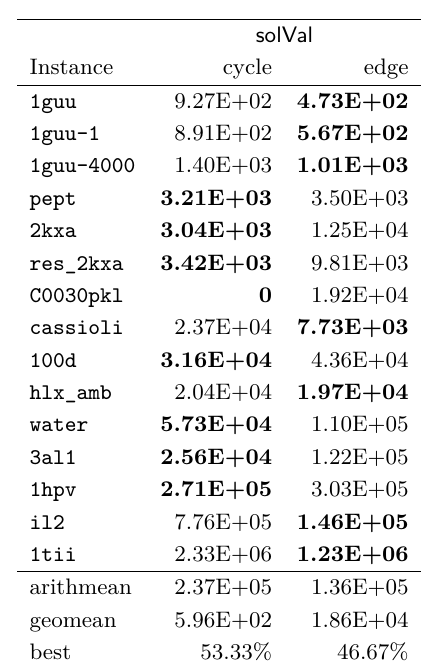
Table 2 MS solution values of cycle formulation vs. edge formulation (realizations in K = 3